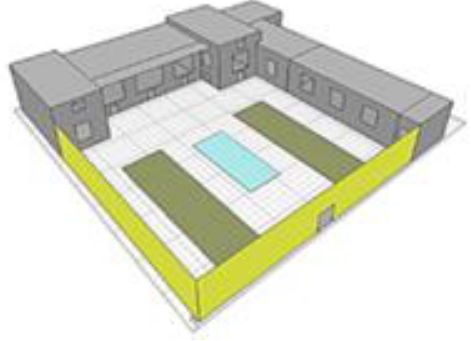
Figure 7 Geometry of house No. 1 (Images 9-23 from the analyses done in software Ecotect) (Source: Author)